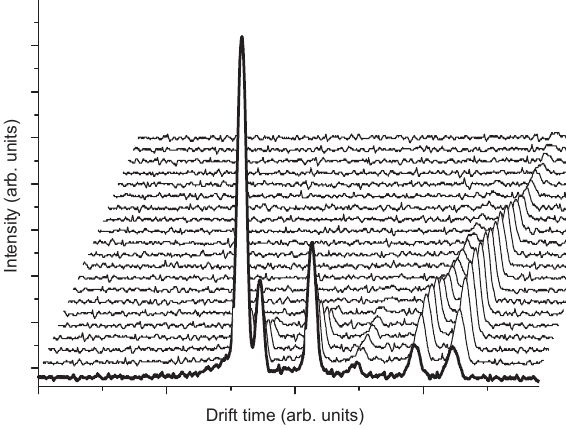
Figure 2 Typical IMS spectrum, shown for a mixture of dimethyl methylphosphonate (DMMP) and dimethylformamide (DMF). The six peaks (from left to right) are RIP, DMF monomer, DMMP monomer, DMF dimer, DMMP + DMF asymmetric dimer, DMMP dimer. Further- more, it is shown how the spectrum changes if a pulsed source is used and the delay time between ionizing electron pulse and ion extraction (with subsequent detection) is increased (each spectrum was recorded 300 μ s after the previous one).